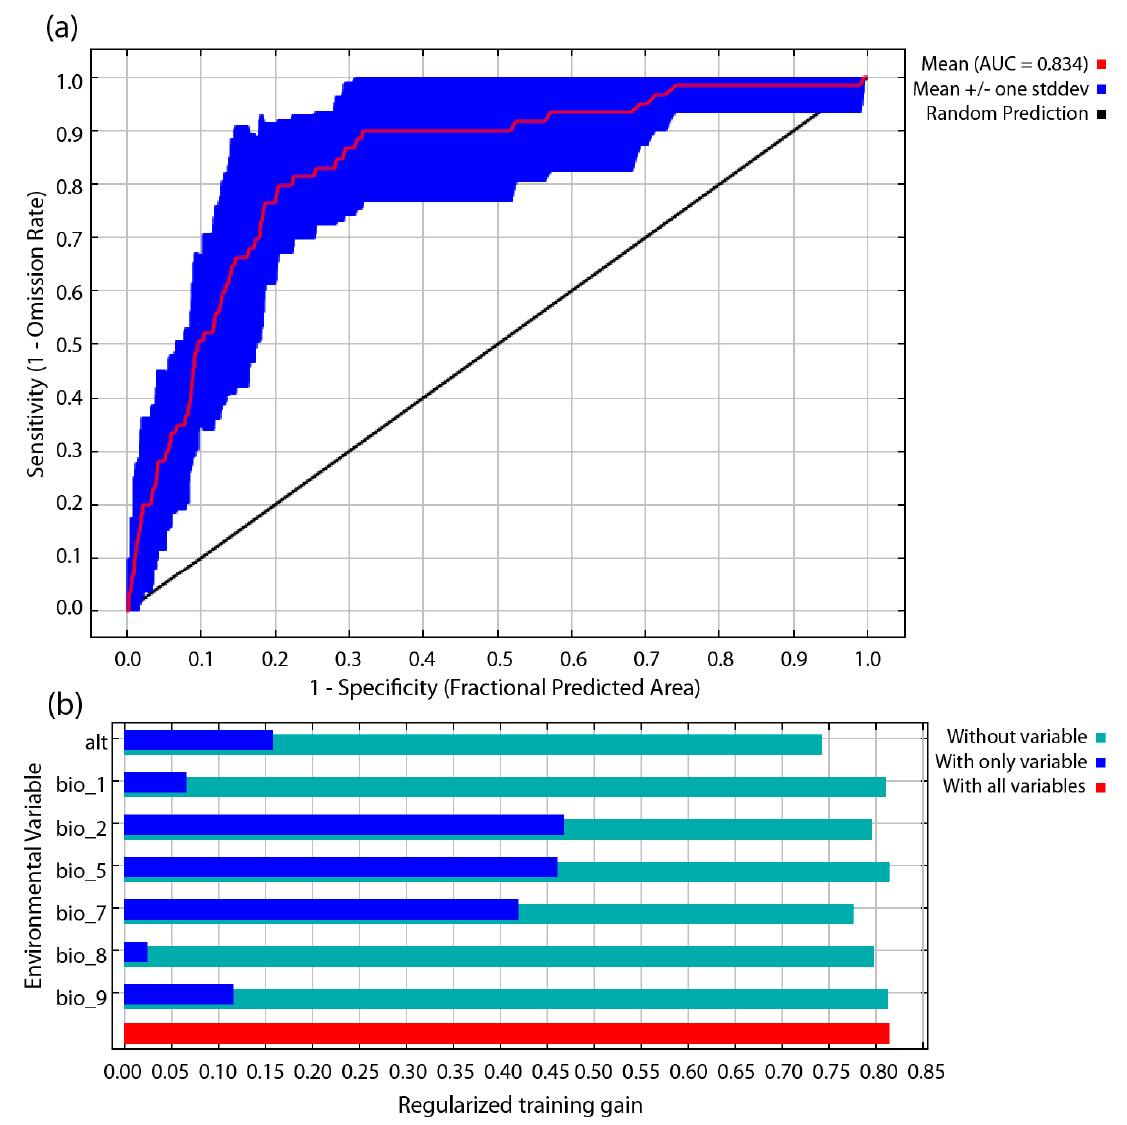
Figure 1. ( a ) Reliability test of the distribution model created for Spogostylum ocyale (values shown are averages over ten replicate runs). ( b ) Jackknife test results for Spogostylum ocyale, showing the relative predictive power of environmental variables. (Without variable)—the importance of the other environmental variables when this variable is omitted; (With only variable)—the importance of the environmental variable when used in isolation; (With all variables)—the importance of all environmental